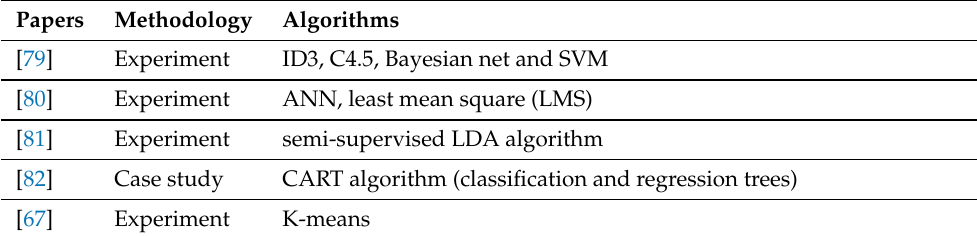
Table 7. Algorithms and approaches used for automatic recommendation, proficiency, classification, and indexing.